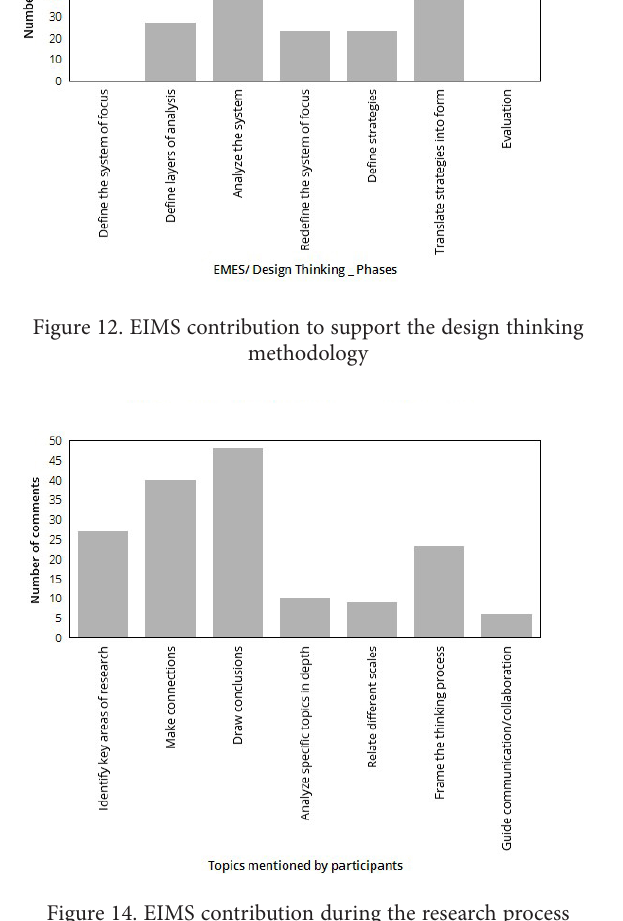
Figure 14. EIMS contribution during the research process Figure 15. EIMS contribution during the design